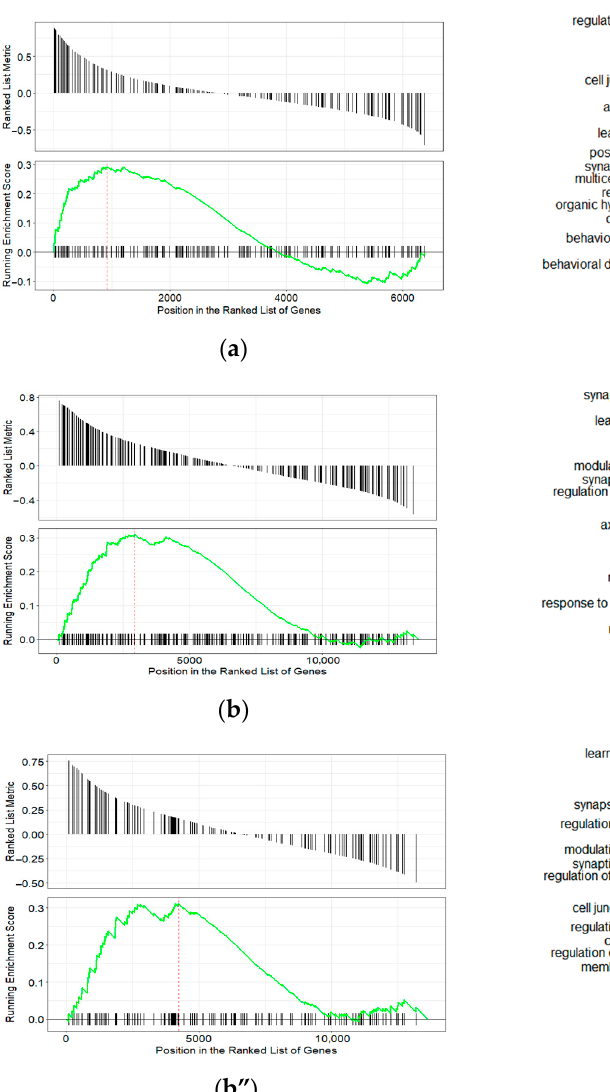
Figure 3. The genes involved in the developmental disorder of mental health co-expressed with DDAH1 and DDAH2 in non-psychiatric subjects. The enrichment plot for the representation of “DOID:0060037: developmental disorder of mental health” Disease Ontology (DO) term in the set of genes ranked based on their co-expression with DDAH1 in non-psychiatric subjects ( a ) and top 10 of biological processes in which enrichment core genes are implicated ( a’ ). The enrichment plot for the representation of “DOID:0060037: developmental disorder of mental health” DO term ( b ) and “DOID:0060037: developmental disorder of mental health” DO term ( b” ). “DOID:0060041: autism spectrum disorder”/” DOID:12849: autistic disorder” in genes ranked based on their co-expression with DDAH2 in non-psychiatric subjects; ( b’ , b’” ) top 10 of biological processes in which enrichment core genes for “DOID:0060037: developmental disorder of mental health” and “DOID:0060041:autism spectrum disorder”/” DOID:12849: autistic disorder” are implicated respectively.